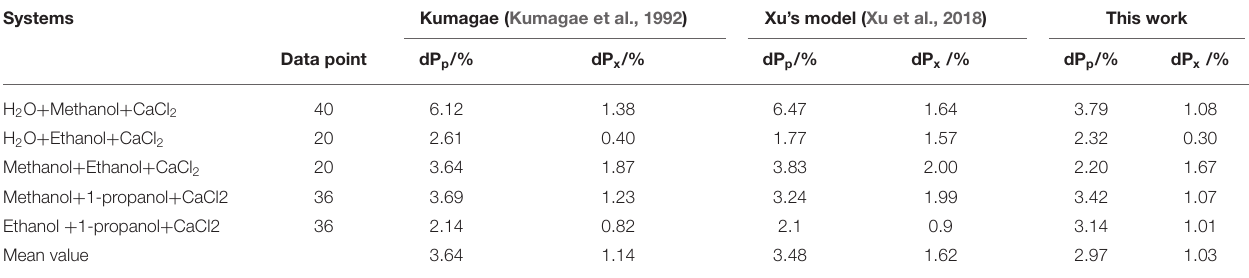
TABLE 7 | Comparison of VLE for systems containing CaCl 2 at 298.15K.